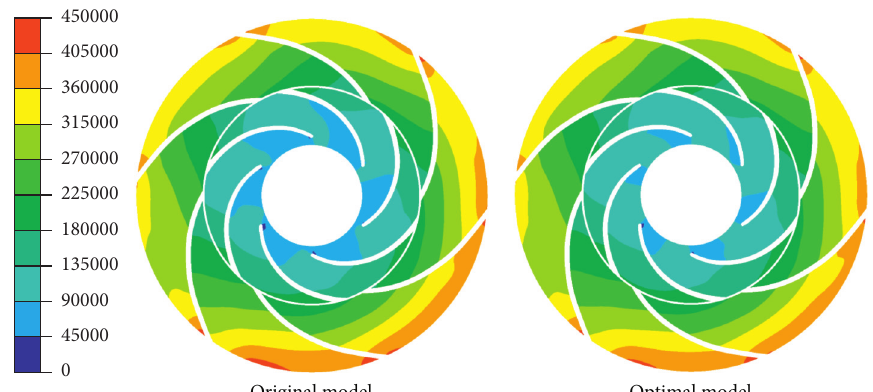
Figure 16: Comparison of pressure distribution at 0.8 Q